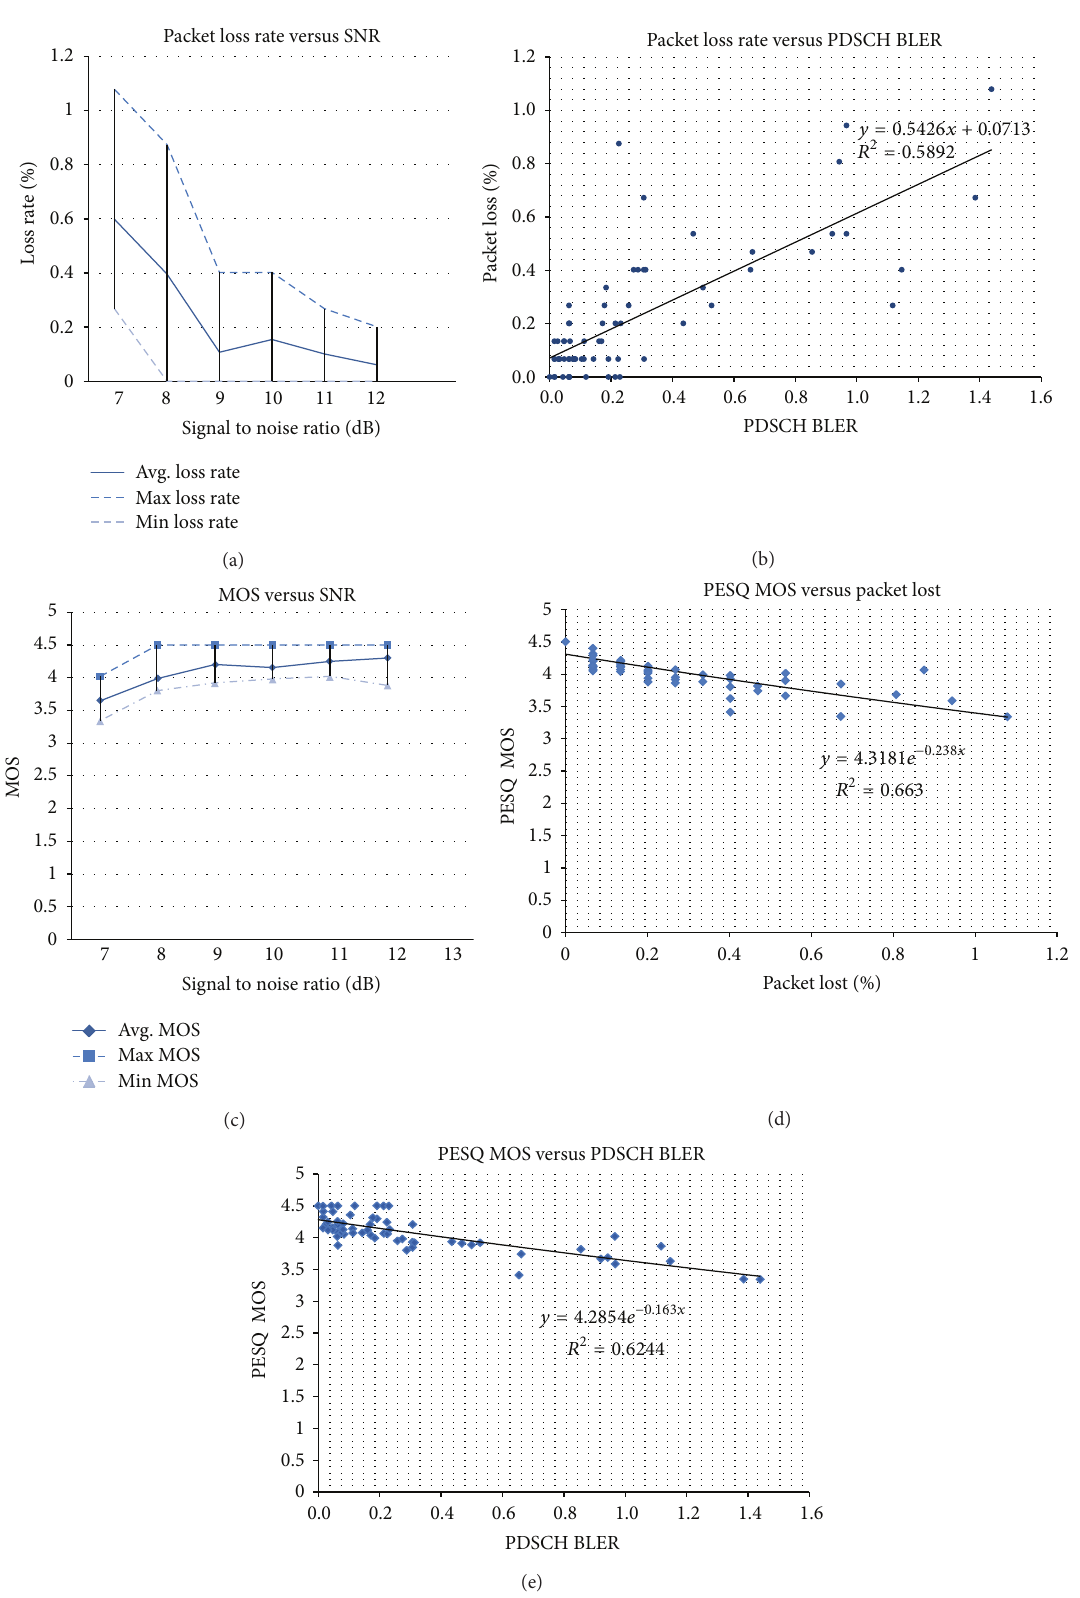
Figure 4: Cross-layer measurements and correlations. (a) Packet Loss versus SNR. (b) Packet Loss versus PDSCH BLER. (c) MOS versus SNR. (d) PESQ MOS versus packet lost. (e) PESQ MOS versus PDSCH